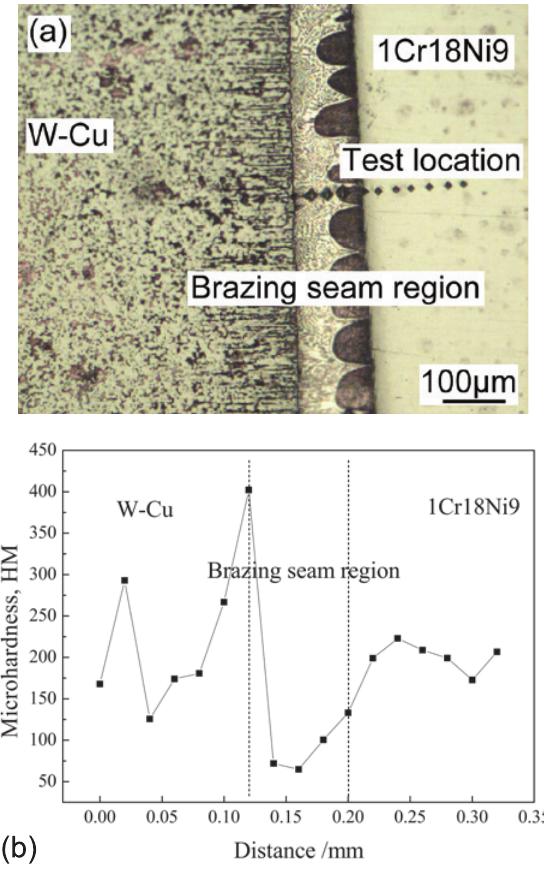
Fig. 6: Microhardness distribution near interface of the brazed